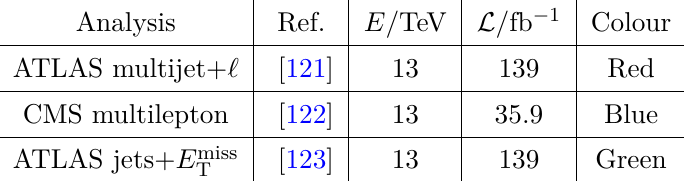
Table 3 . Analyses in CheckMATE which are relevant for RPV